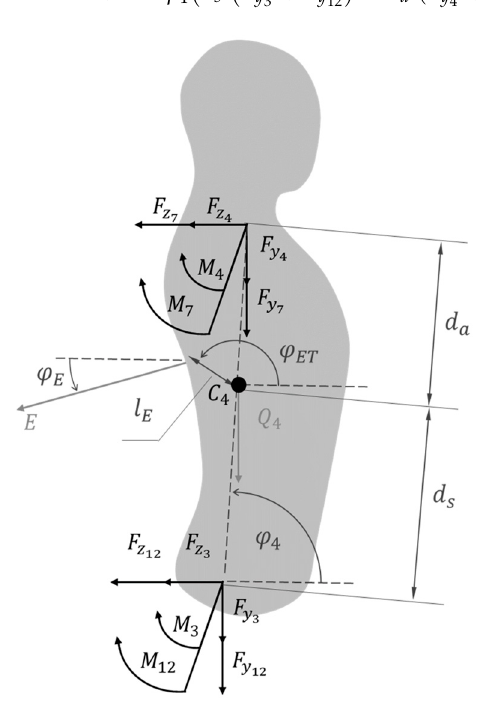
→ E stands for the